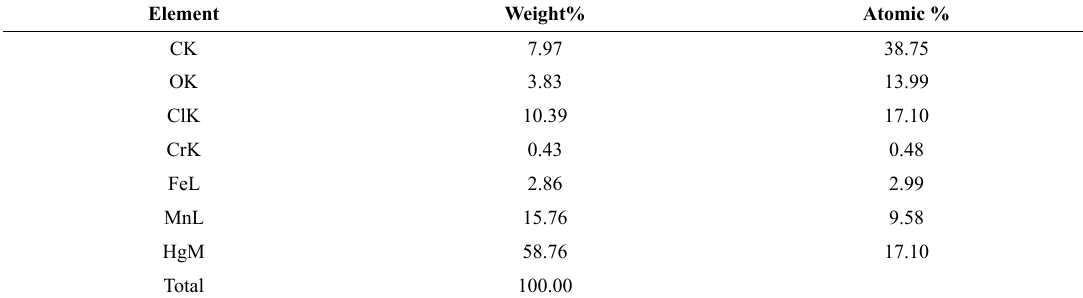
Table 2. Energy dispersive X-ray analysis